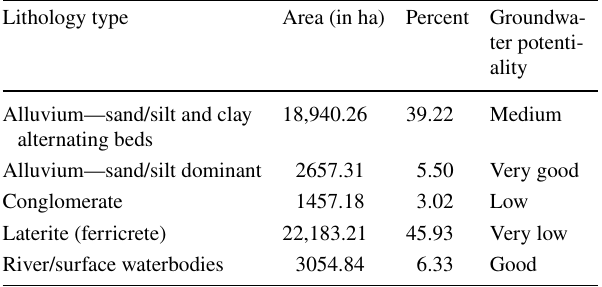
Table 4 Lithological characteristics and their areal extent of Gopibal-